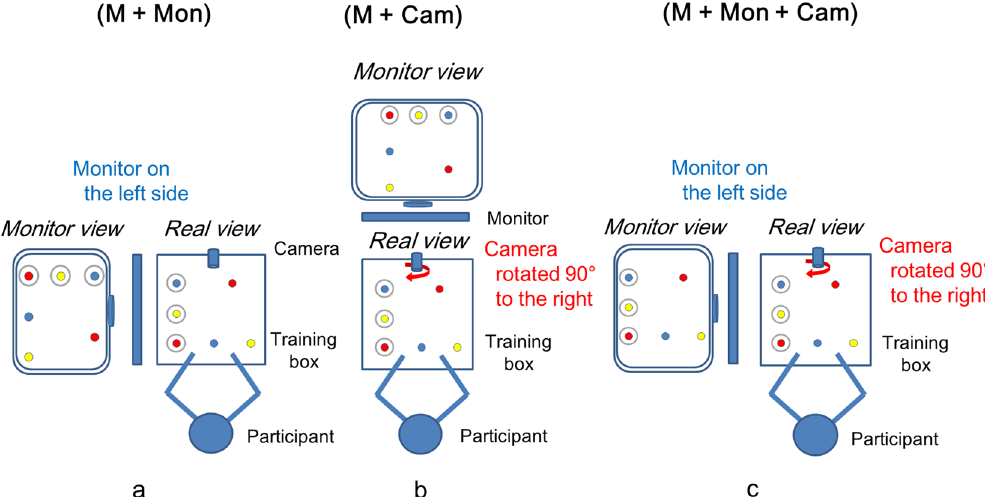
Figure 4. Setup of the training box for the experimental conditions. ( a ) Mirror image + Monitor on the left side (M + Mon): the monitor was placed on the left side of the participant in mirror image. The difference in angle between the actual view and the view on the monitor seemed to be reduced to 90 degrees. ( b ) Mirror image + Camera rotated 90 degrees to the right (M + Cam): the camera was rotated 90 degrees to the right in mirror image. The difference in angle between the actual view and the view on the monitor was reduced to 90 degrees. ( c ) Mirror image + Monitor on the left side + Camera rotated 90 degrees to the right (M + Mon + Cam): the monitor was placed on the left side of the participant and the camera was rotated 90 degrees to the right in mirror image. The difference in angle between the actual view and the view on the monitor seemed to be reduced to 90